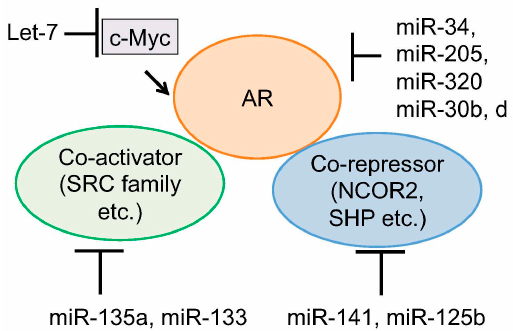
Figure 2. Regulation of AR activity by miRNAs. Several miRNAs were reported to directly target AR mRNA to reduce AR protein level. Another mechanism is to inhibit expression level of AR coregulators or associated transcription factors by miRNAs.